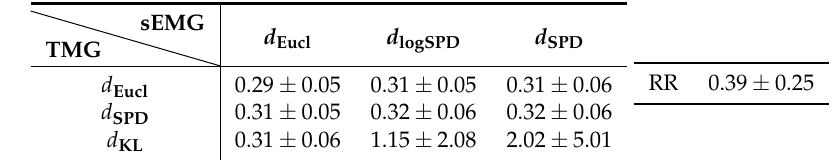
Table 3. Performance in term of root mean square error (RMSE) of ridge regression (RR) and Gaussian process regression (GPR) with different distances combining surface electromyography (sEMG) and tactile myography (TMG) as input for the regression